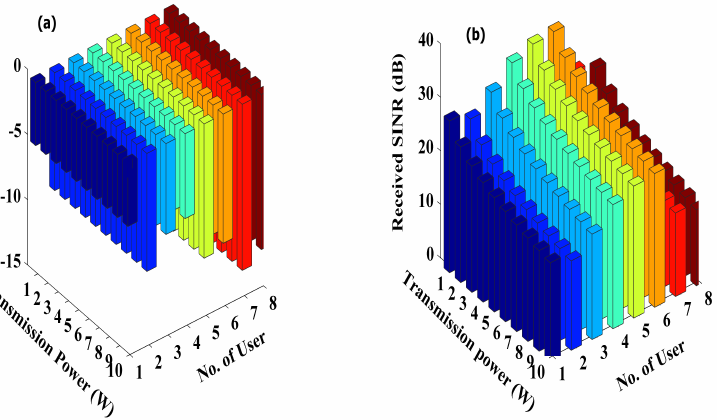
Figure 7. Estimated average received signal to interference noise ratio (SINR) when both gyre decoding and inverse T-transformation schemes are ( a ) absent and ( b )